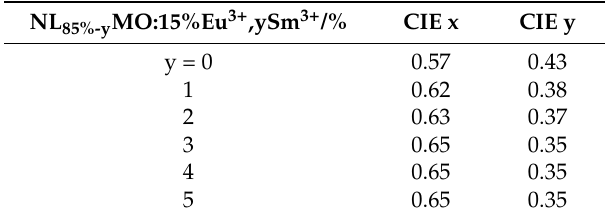
Table 2. CIE chromaticity coordinates (x, y) of NL 85%-y MO:15%Eu 3+ ,ySm 3+ (y = 0, 1, 2, 3, 4 and 5%) excited at 464